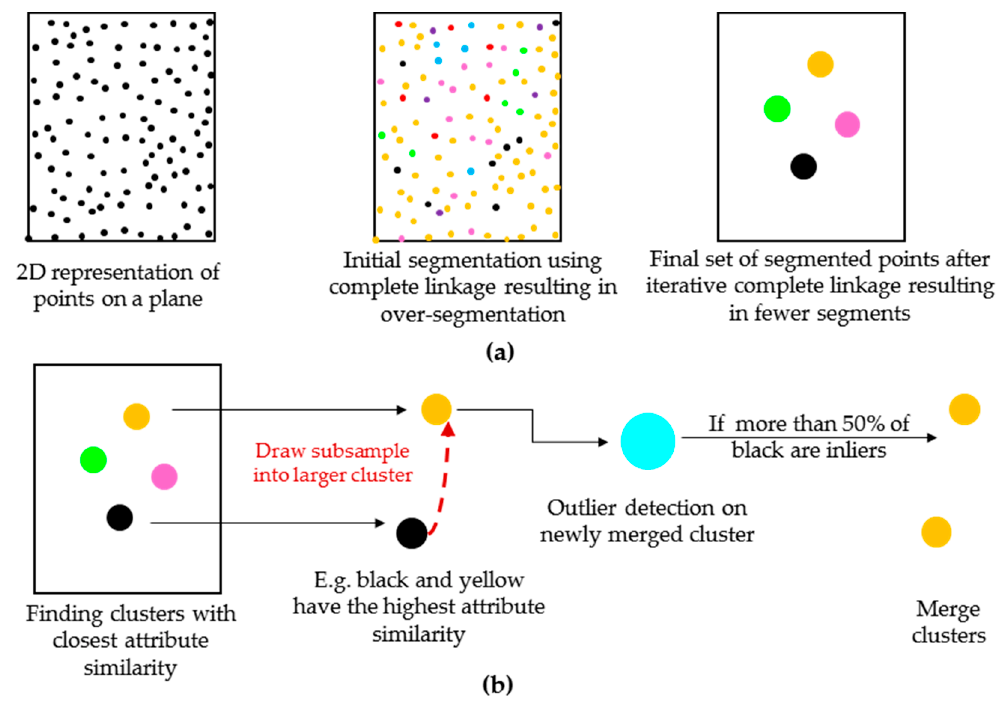
Figure 4. 2D representation of the proposed segmentation framework (each coloured circle represents a segment): ( a ) iterative complete linkage; and ( b ) robust complete linkage.